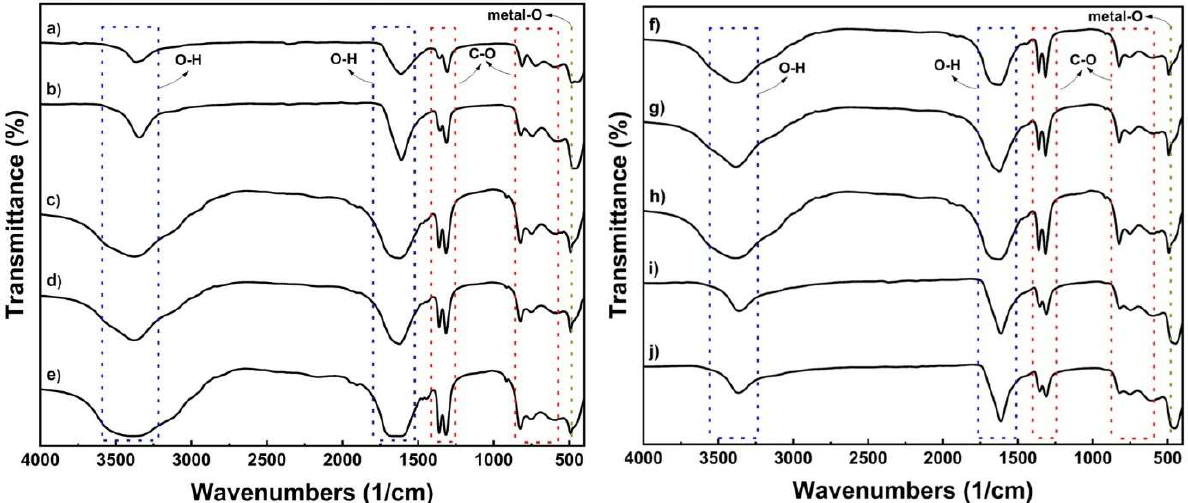
Table 3. The temperature in the dehydration and decomposition stages of the precursor.